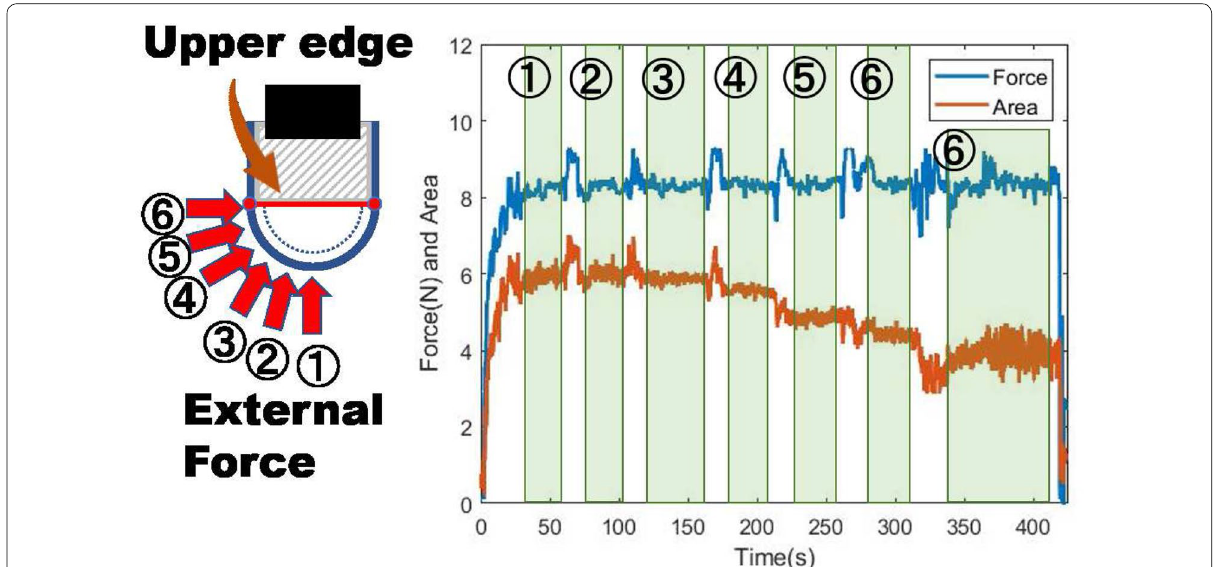
Fig. 10 Relationship between a contact force and the change in the triangle area according to a contact position: the change in the triangle area depends on where the contact position is located on the fingertip even if the magnitude of the applied forces is